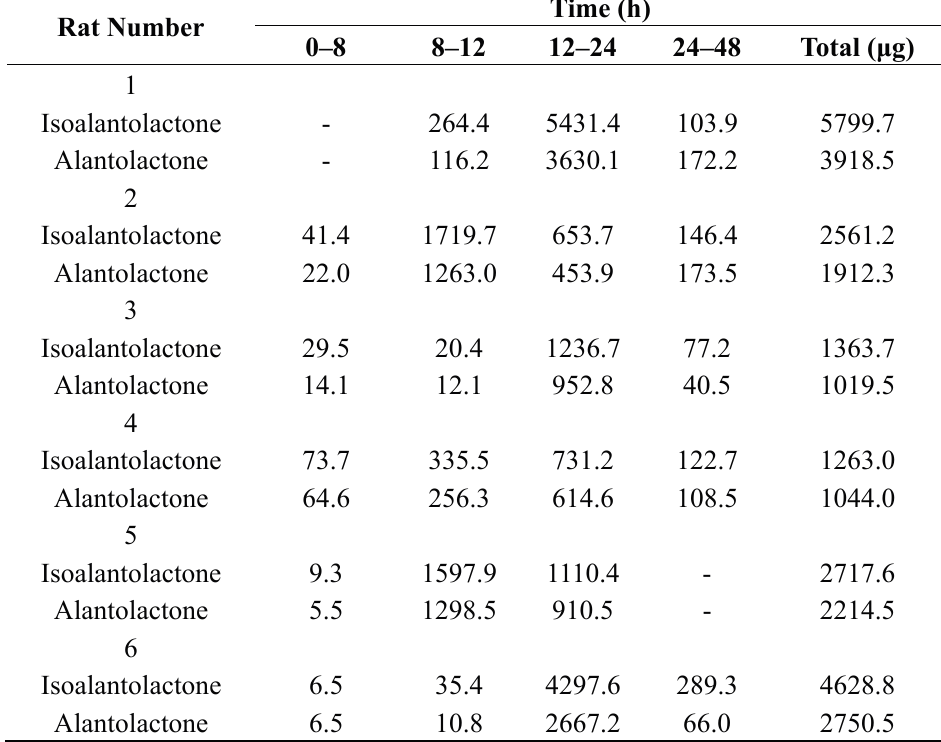
Table 6. Excretion of lactones in rats feces after a single oral administration at 90